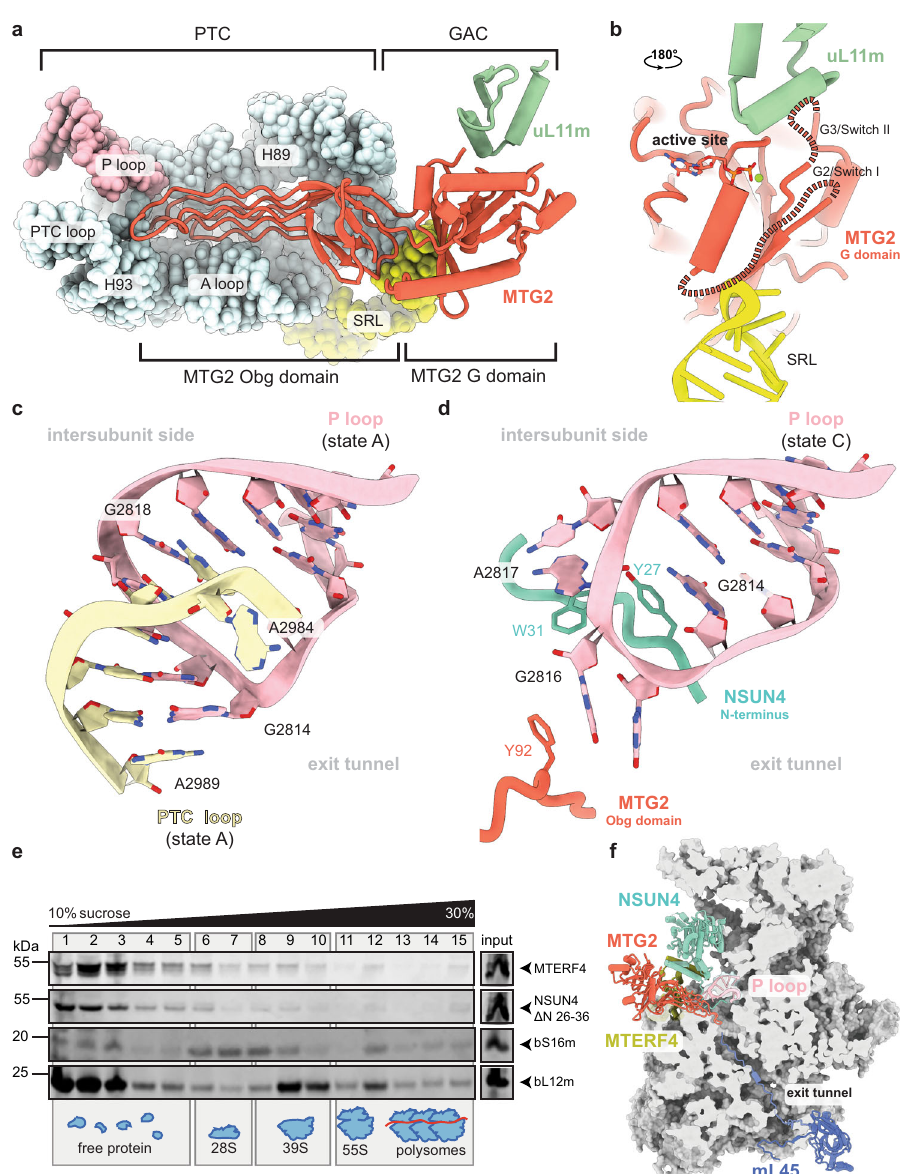
Fig. 3 Mitochondrial GTPase MTG2 interacts with the functional regions of the immature human mitoribosomal large subunit. a Interaction of the MTG2 (red cartoon) with the 16S rRNA and ribosomal proteins in state C. The N-terminal Obg domain of MTG2 contacts the peptidyl transferase center (PTC) region of the 16S rRNA (light cyan, PTC helices depicted individually, P loop in pink), whereas the G domain associates with the ribosomal GTPase- associated center (GAC) components uL11m (green) and the sarcin-ricin loop (SRL). b Detailed view of G domain interactions with the GAC rotated by 180° relative to panel (a). The Switch loops I and II are schematically indicated as dashed lines. The color key is the same as in panel ( a ). c The 16S rRNA PTC loop (light yellow) stacking with the P loop (pink) as a result of an immature rRNA arrangement in state A. d Speci fi c interactions of the NSUN4 N- terminal tail (teal) and the MTG2 Obg domain (red) with the P loop (pink). Amino acid residues involved in coordinating the P loop are highlighted. e Effects of N-terminal deletion of residues 26 – 36 in NSUN4 on its association with mitoribosomal fractions and 55S monosome formation were determined by immunoblotting. A continuous 10 – 30% sucrose gradient was used to separate mitochondrial lysates from HEK 293T cells expressing the MTERF4 and NSUN4 mutant to determine their distribution and co-migration with mitochondrial ribosomal fractions. The small and large ribosomal subunit and polysomes in mitochondria isolated from NSUN4 Δ N 26-36 transfected cells were followed by immunoblotting for mitochondrial ribosomal protein markers of the small (bS16m) and large (bL12m) ribosomal subunits. The input mitochondrial lysate was used as a positive control. The blots are representative of results obtained with at least three independent biological experiments. Source data are provided as a Source Data fi le. f Cross-section of the mitochondrial large subunit state C assembly intermediate. The spatial arrangement of assembly factors NSUN4 (teal), MTERF4 (light green), and MTG2 (red) ensure probing of the P loop (pink) and the entrance to the nascent polypeptide tunnel in the mitochondrial large subunit assembly intermediate (gray). The mL45 (blue) N-terminal tail occupies the exit tunnel, contributing to an inactive state of the